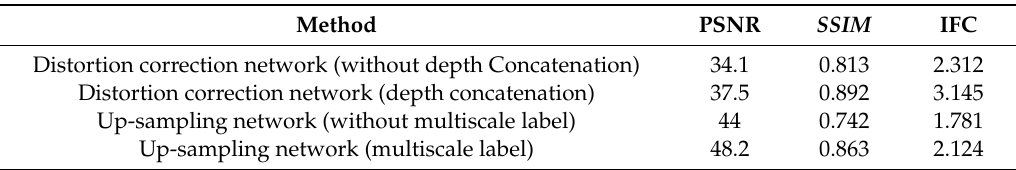
Table 5. The network of di ff erent steps in this system was a ff ected by the size of the convolution kernel. PSNR—Peak Signal to Noise Ratio; IFC—Information Fidelity